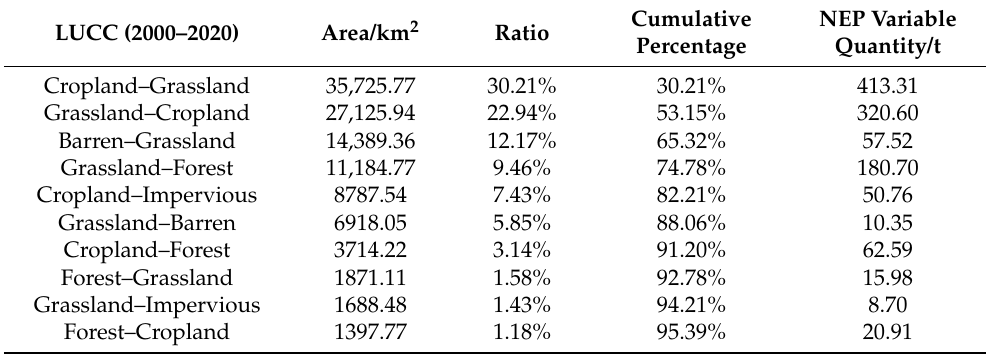
Table 2. LUCC and its impact on NEP in the Yellow River basin from 2000 to 2020.